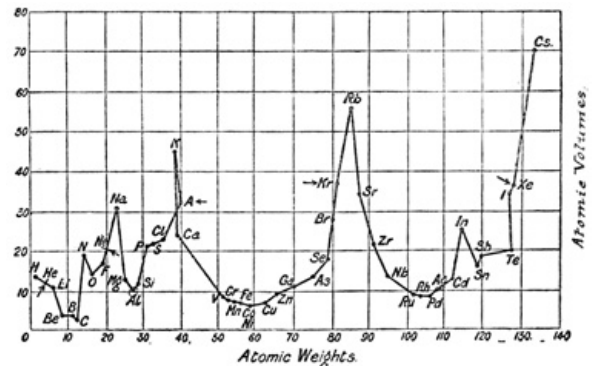
Figure 4. Lothar Meyer’s graph showing